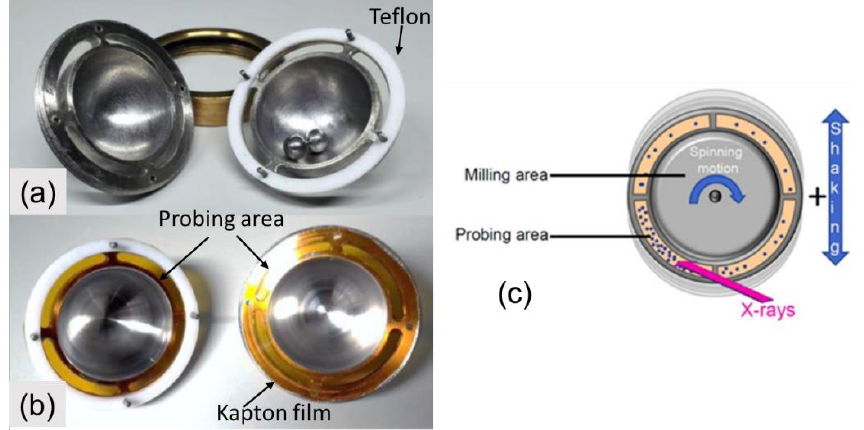
Figure 5. ( a ) Two half-shells forming the milling jars with the perforated outer part, ( b ) the milling jars with a Kapton film protecting the probing area, and ( c ) scheme of the milling jar showing the movement of the jar on the mill. Adapted with permission from [54]. Copyright 2017, American Chemical Society.